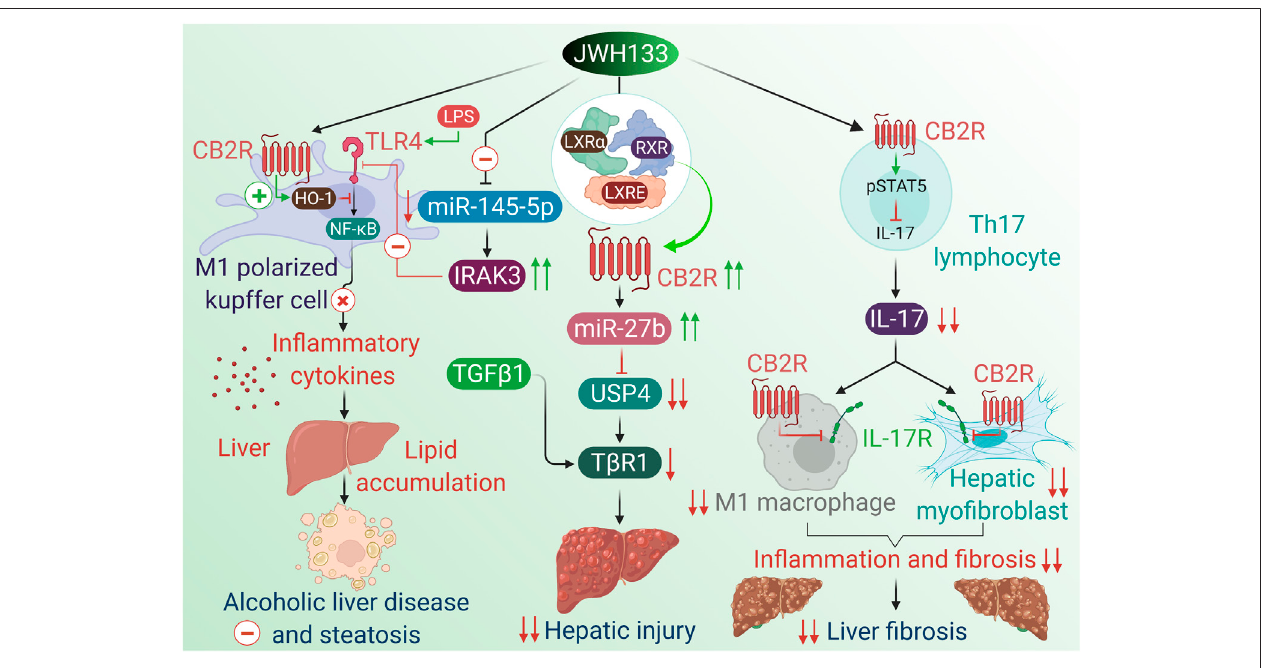
FIGURE 4 | The hepatoprotective effects and mechanism of